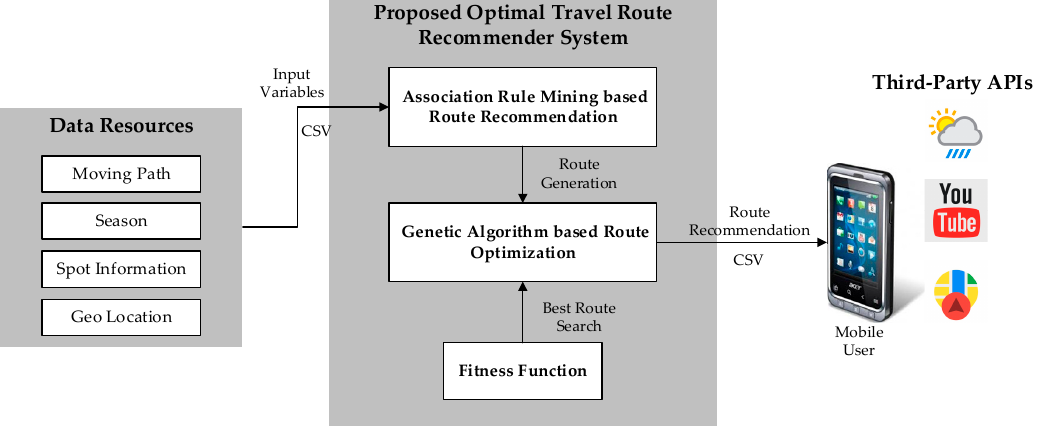
Figure 1. Conceptual architecture of the optimal travel route recommender system.